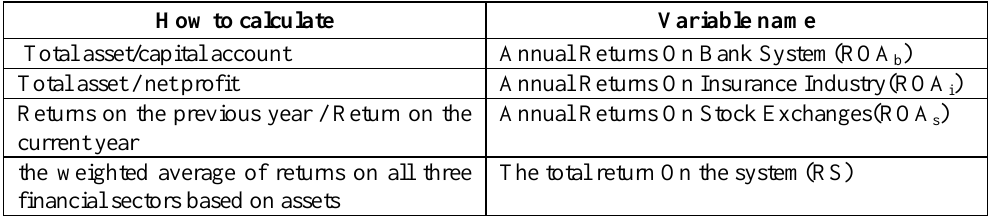
Table 2. Research variables and how to calculate